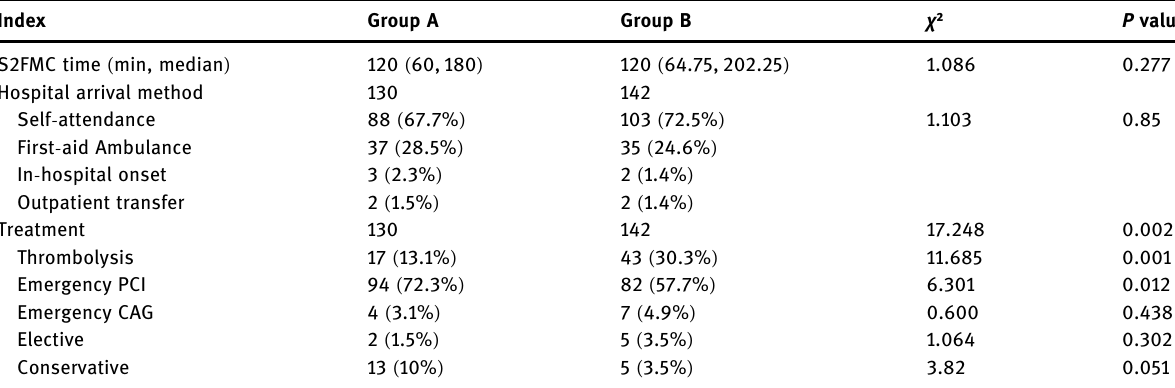
Table 2: Comparison of treatment situations between groups ( %, Q1, Q3 )